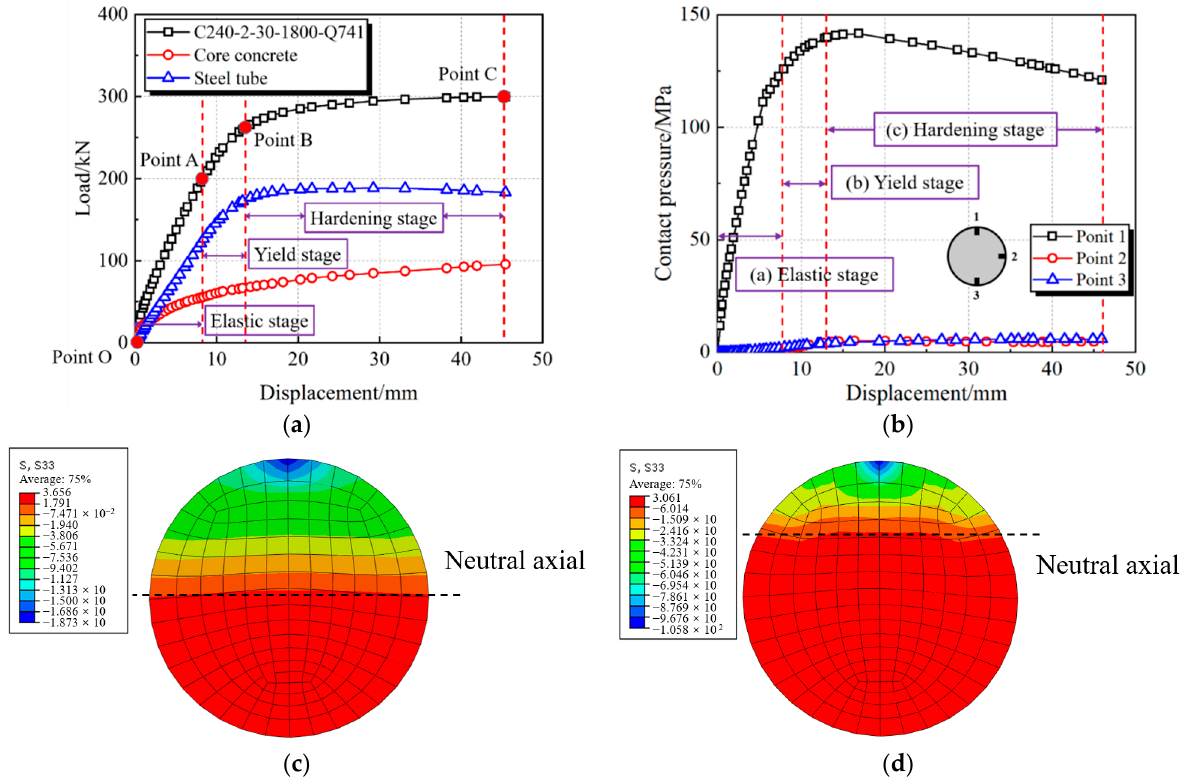
Figure 12. Full-range analysis on a typical CFHST member. ( a ) Load–displacement relation; ( b ) Interaction behavior; ( c ) Elastic stage; ( d ) Yield stage.